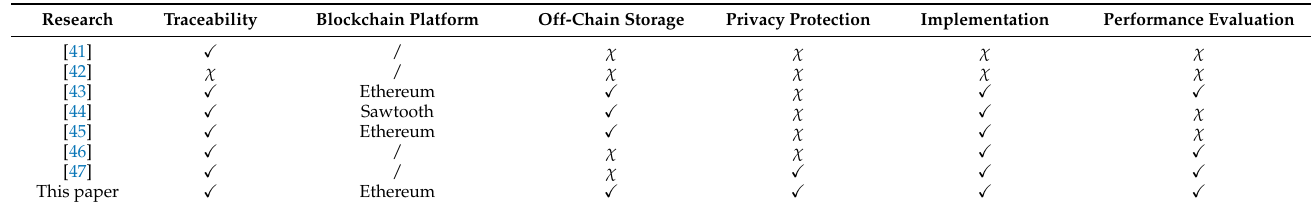
Table 11. Comparison of the proposed system to related